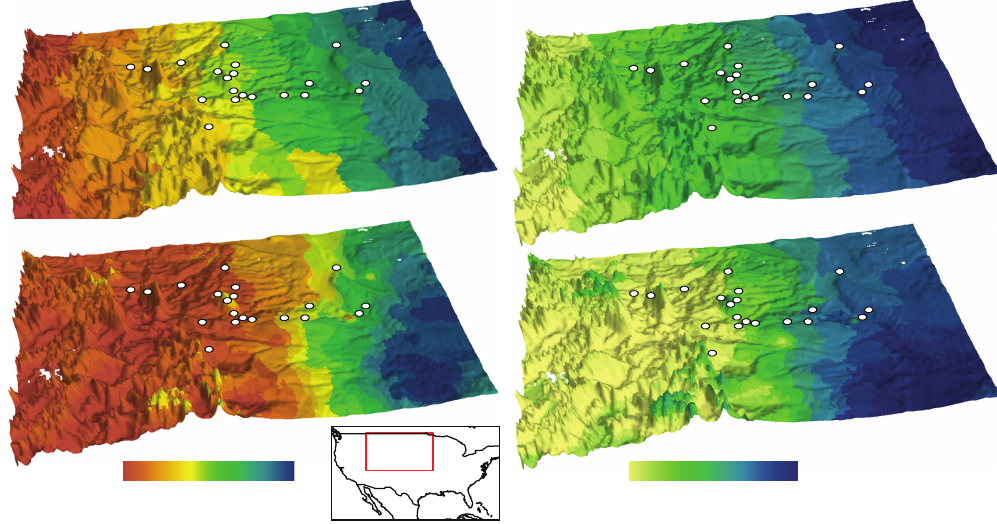
Figure 2: Generalized dissimilarity modeling results of the proportion of pure P. amoena individuals, plus one half of the hybrid individuals, in a population. Left two panels: “80–20” criterion; right two panels: “90–10” criterion. Top two panels: full model (including both geographic distance and environmental variables); bottom two panels: models for only environmental variables. Colors indicate the proportion of pure P. amoena individuals, plus one half of the hybrid individuals, in the population (brown/tan 100%, blue =